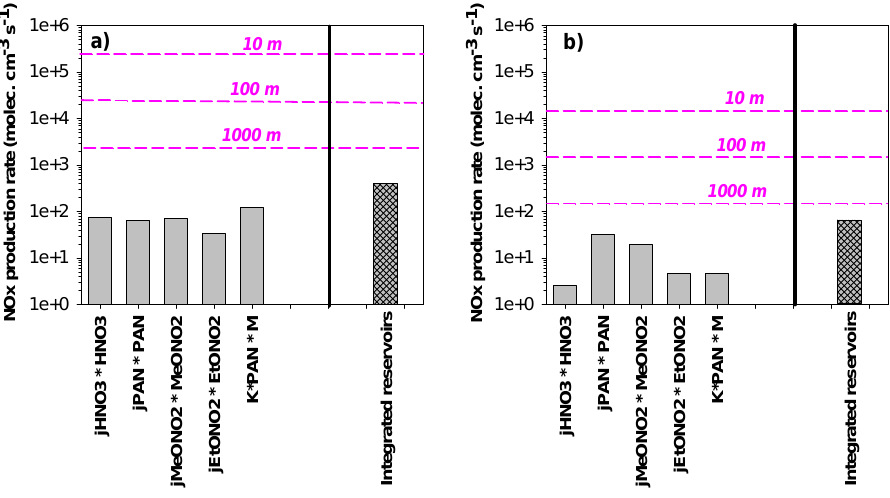
Fig. 6. Rate of NO x production from gas phase reactions as 24-h averages during (a) summer (January) and (b) spring (September). Also shown (pink dashed lines) is the NO x produced directly from photolysis of snowpack nitrate assuming boundary layer heights of 10m, 100m and 1000m. Note the log